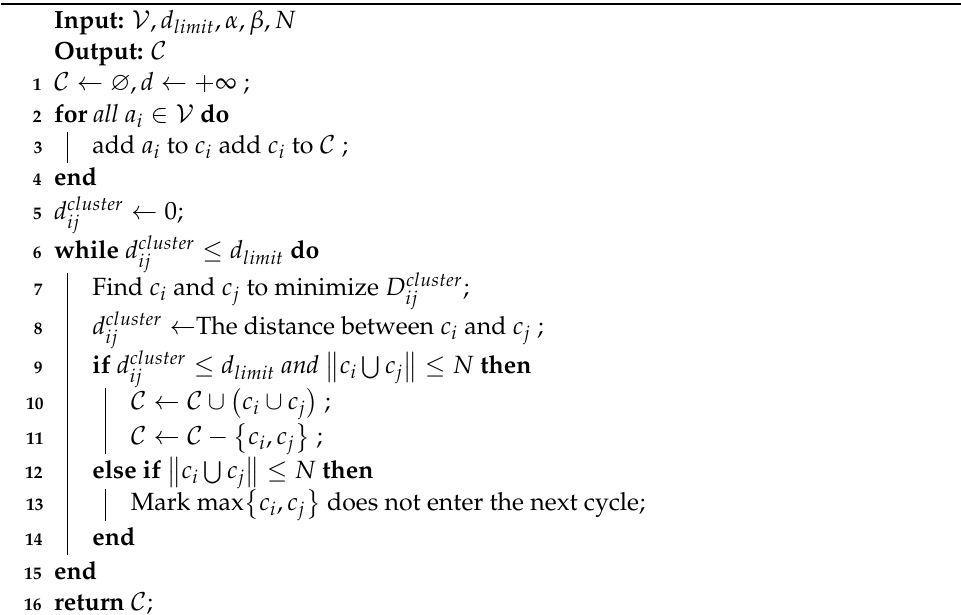
Algorithm 1: Vehicle Clustering. The algorithm is used to complete the vehicle clustering.